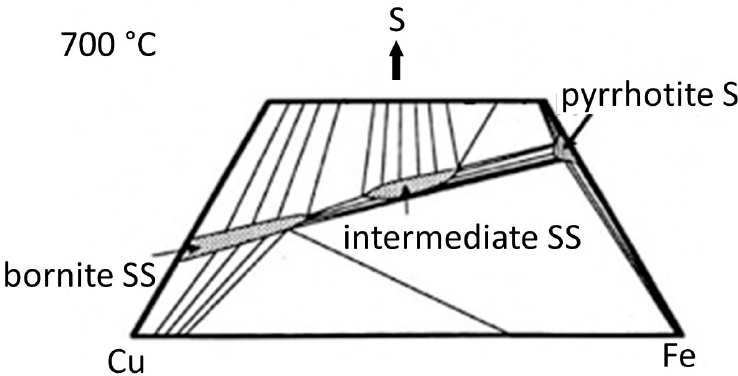
Figure 15. 700 °C isothermal section of Fe-Cu-S phase diagram. SS solid solution, based on Yund and Kullerud [44].